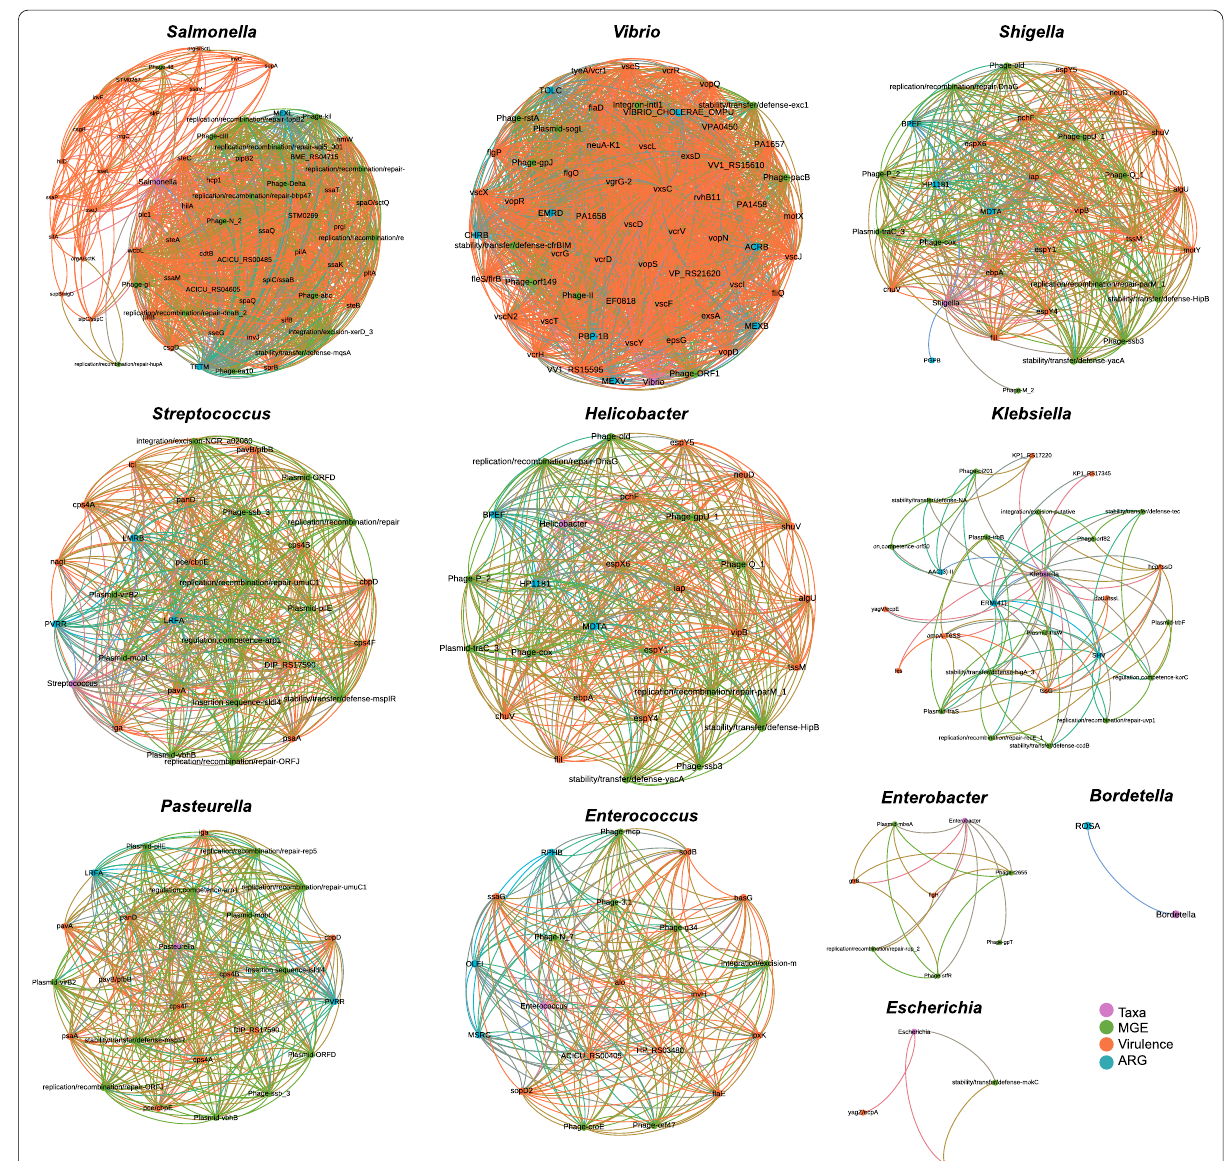
Fig. 9 Ego networks of taxa of public and animal health interest identified through mNGS of feces from Galapagos marine